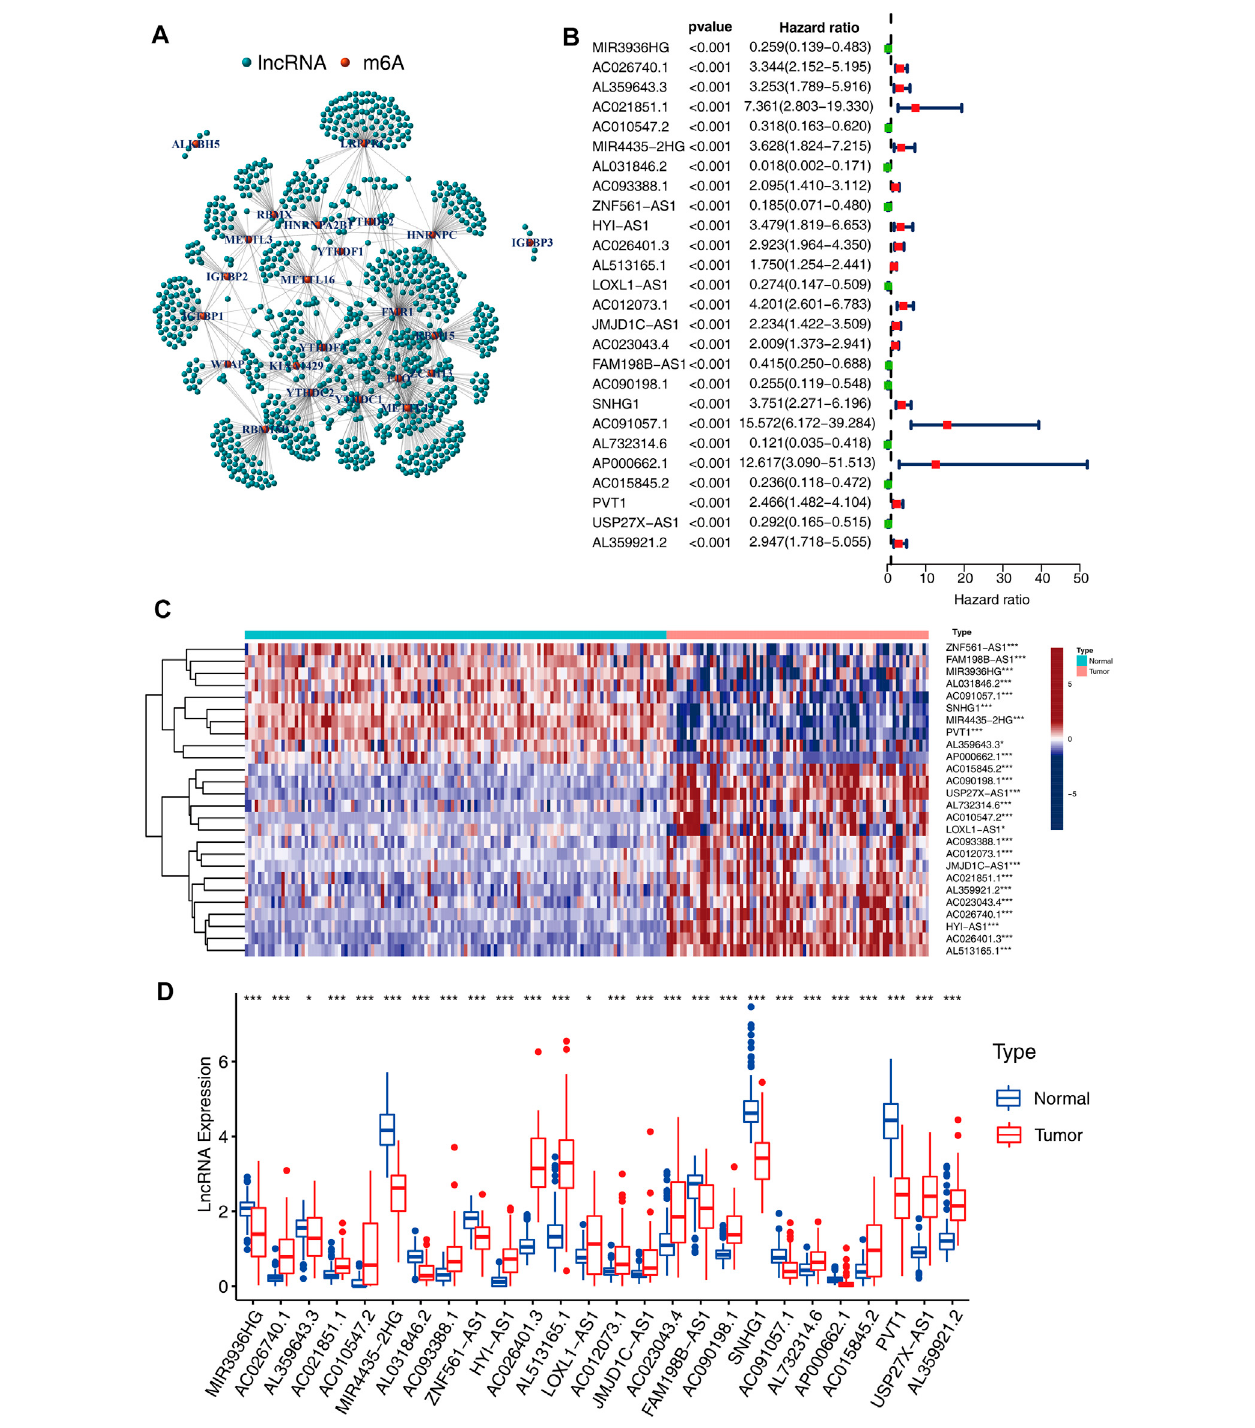
FIGURE 2 | Interactions between m6A-related modulators and lncRNAs. (A) The complex modulatory network of 21 m6A-related regulators and lncRNAs. (B) 26 m6A-related lncRNAs have a signi fi cant correlation with the ACC patients ’ OS. (C) Heatmap illustrating the differential expression of the 26 lncRNAs between 127 normal tissues and 79 tumor tissues (* p < 0.05; *** p < 0.001). (D) Boxplot depicting the differential expressions of the 26 lncRNAs.